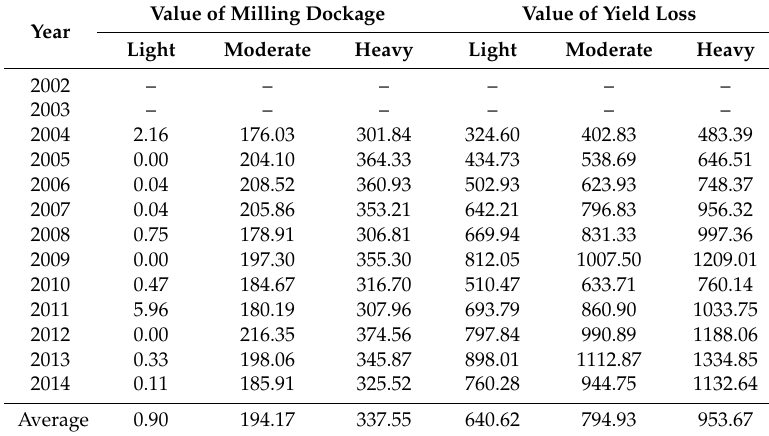
Table 3. Estimated loss ($ ha − 1 ) from milling dockage and yield losses for hybrid non-Clearfield ® rice types under the light, moderate, and heavy levels of initial red rice infestation: 2002–2014.